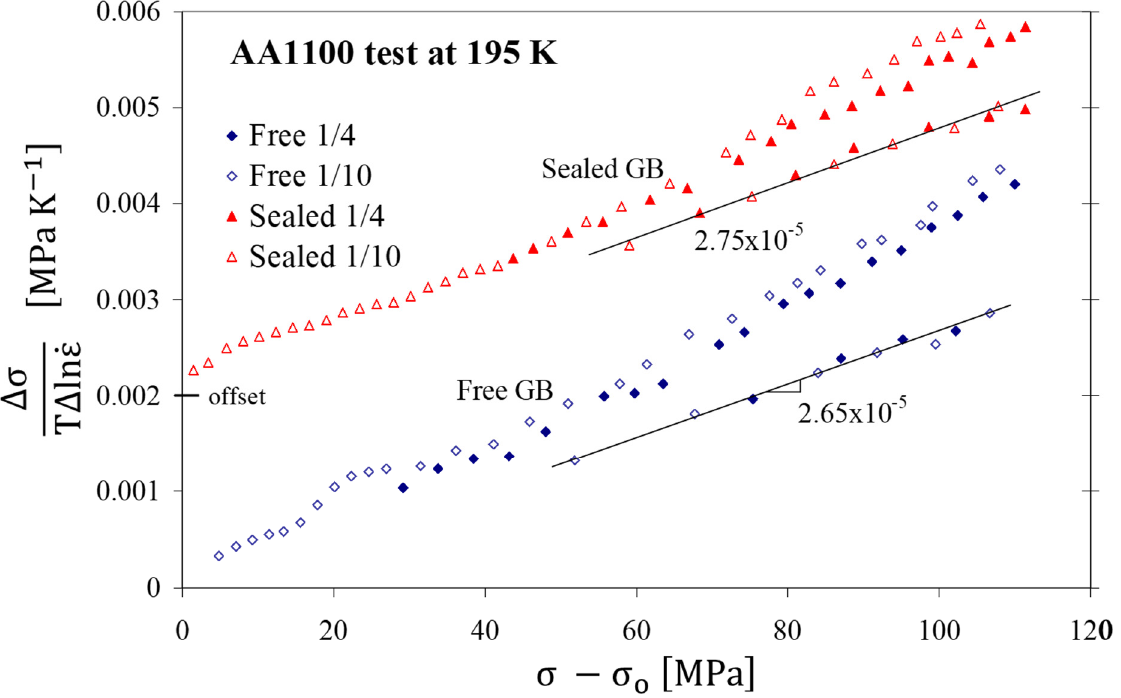
Figure 7. Comparison of Haasen plots at 195 K. Note that beyond yielding a small hump is observed for the free-GB but not for the sealed-GB. The denoted slopes from up-change (Sup) are similar and in both cases the ¼ and 1/10 changes fall on the common line.